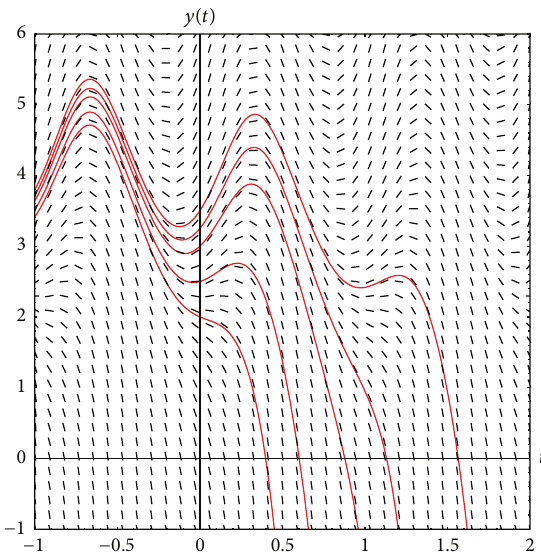
Figure 11: Several solutions to (50) for 𝜎 = 2.396